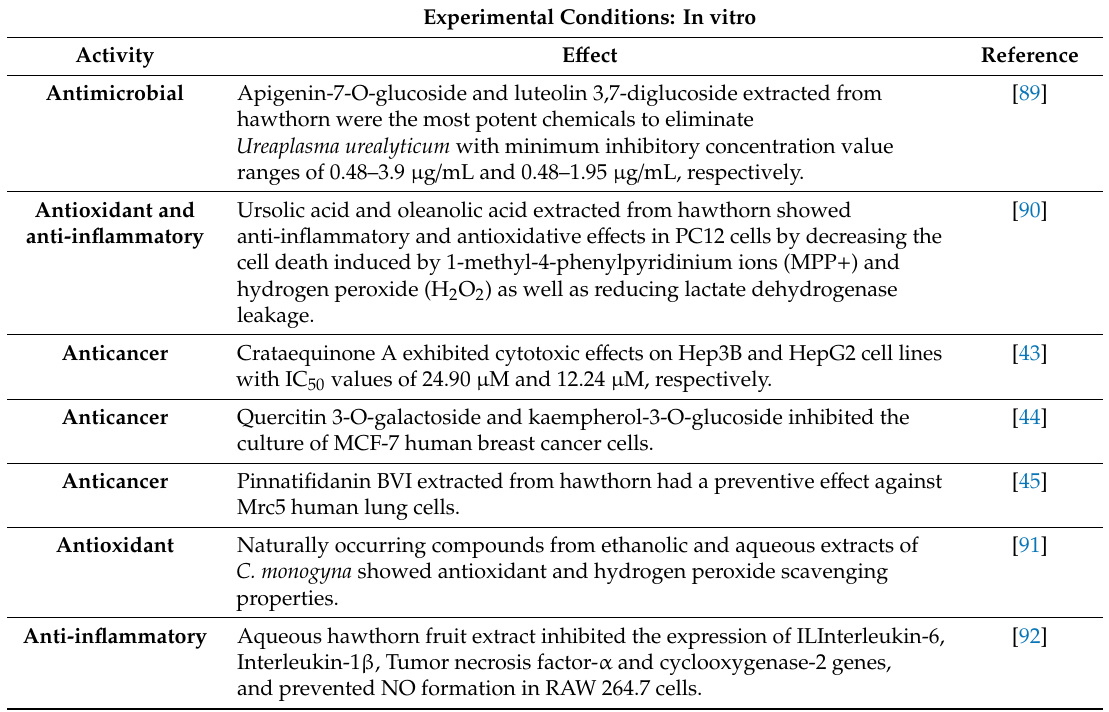
Table 2. In vitro reported activities for